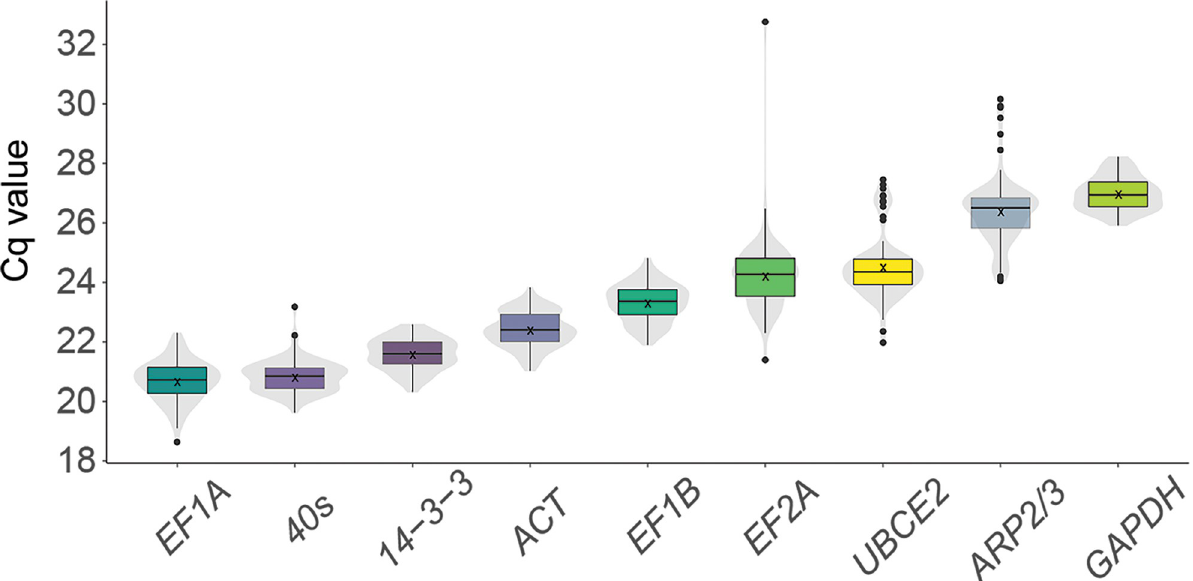
Fig 1. Expression level of tested housekeeping genes. The distribution of Cq (quantification cycle) values of 9 reference genes pooled across 30 samples (15 experimental conditions x 2 time-points) obtained using qPCR. The boxplot marks the median (line) and 25 th (lower) and 75 th (upper) percentile; x marks the mean; the underlying violin plots show the data distribution for each housekeeping gene. Outliers are depicted as black dots. Data for individual experimental conditions may be found in S4 Fig.